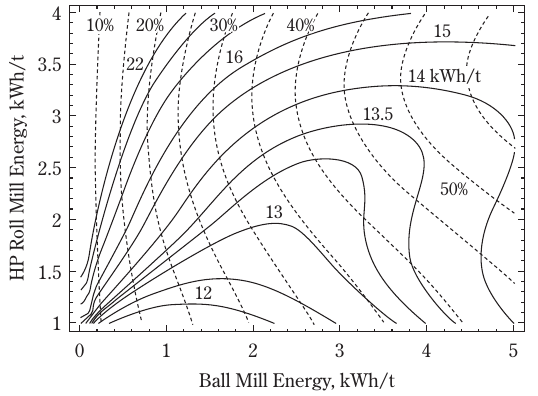
Fig. 12 Relationship between specific grinding energy (solid lines) and the percentage of minus 200 mesh (74 µ m) fines produced (dashed lines) at different energy inputs in the high-pressure roll mill and the ball mill in open-cir- cuit hybrid grinding of Pittsburgh No. 8 bituminous